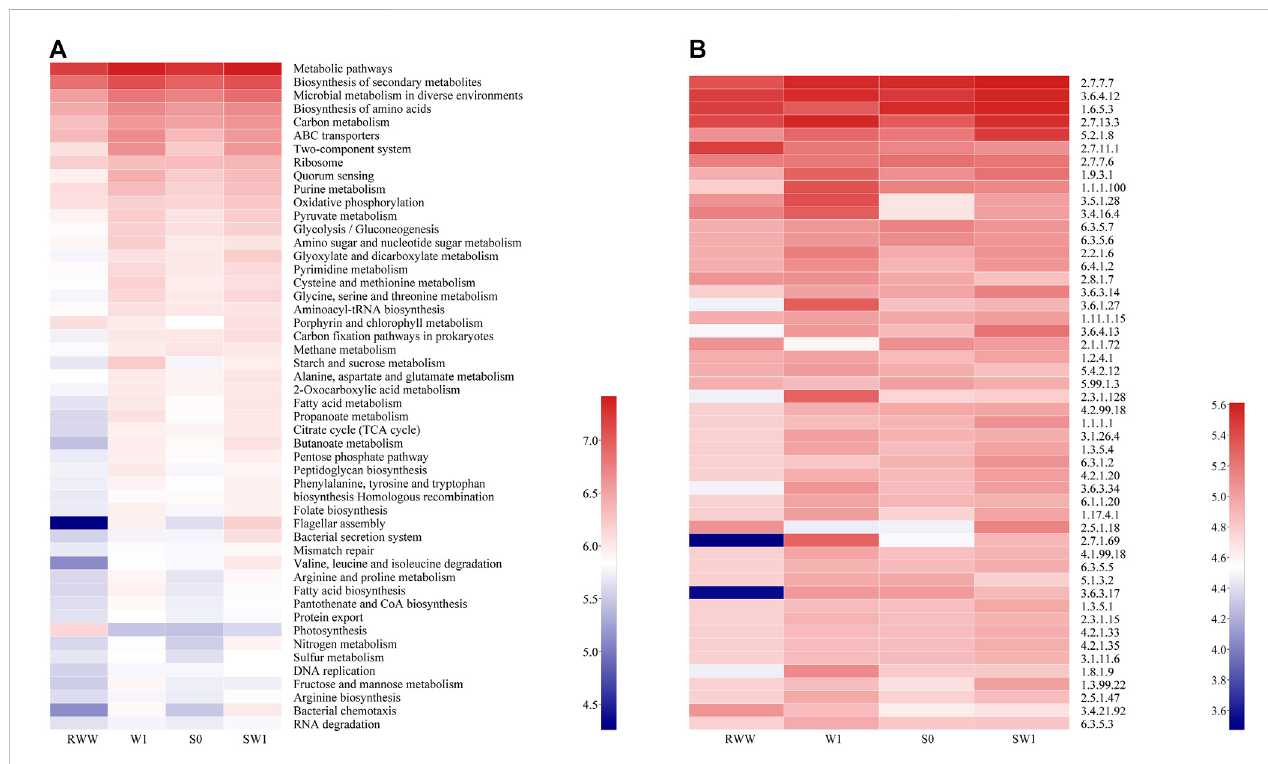
FIGURE 5 Heatmap of pathway level 3 (A) and enzyme (B) through PICRUSt 2 analysis based on the KEGG